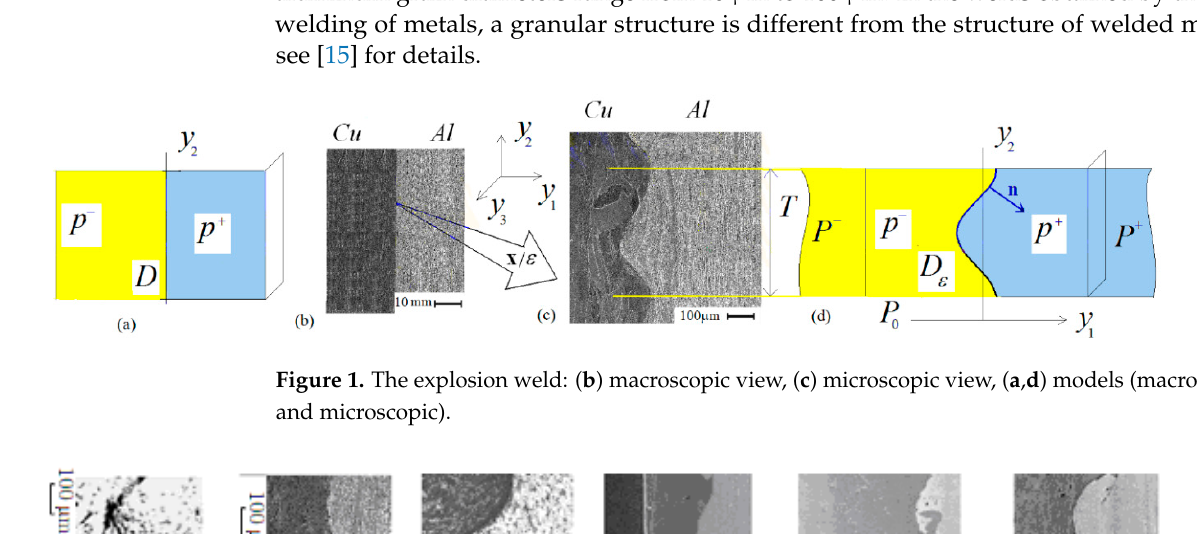
Figure 1. The explosion weld: ( b ) macroscopic view, ( c ) microscopic view, ( a , d ) models (macro- scopic and microscopic).